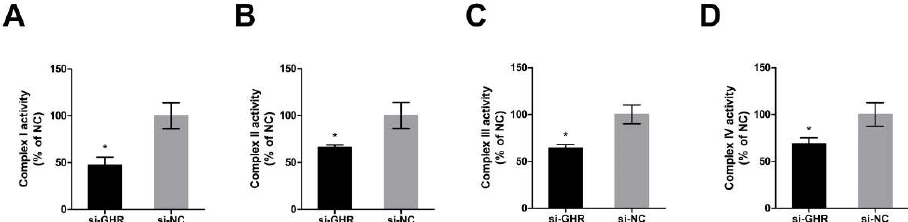
Figure 5. Knockdown of GHR reduced the enzymatic activity of OXPHOS complexes in DF-1 cells. ( A ) Enzymatic activity of complex I was measured by the change in absorbance of NADH at 48 h after transfection with si-GHR and si-NC fragments in DF-1 cells. ( B ) Enzymatic activity of complex II was measured by the change in absorbance of DCIP at 48 h after transfection with si-GHR